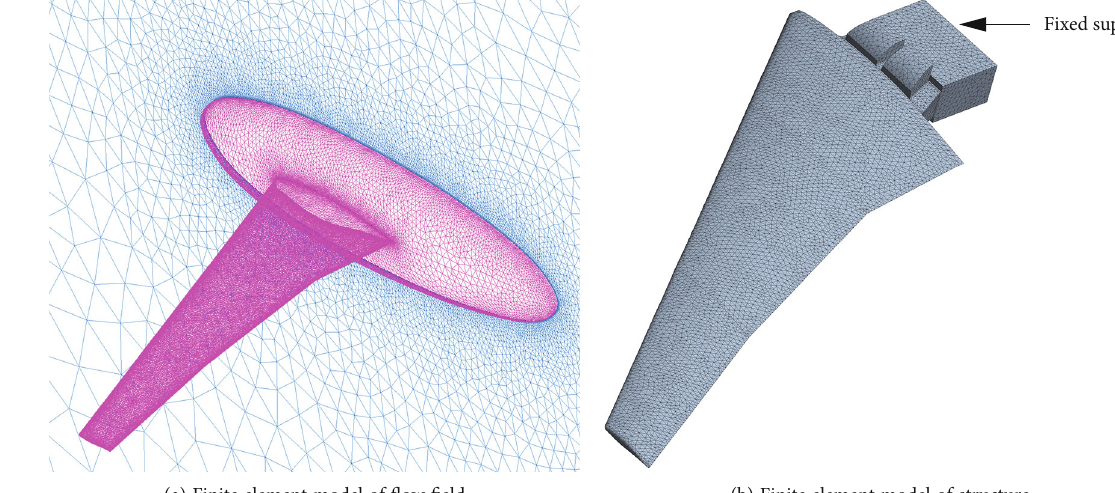
Figure 4: HIRENASD wing fi nite element